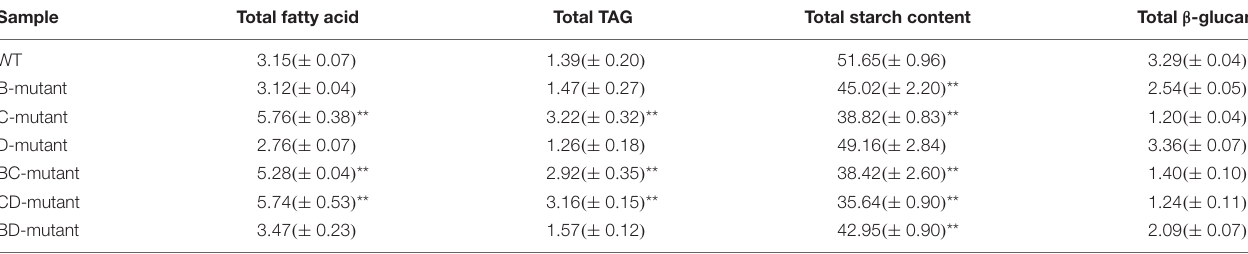
TABLE 1 | Total content of fatty acid, TAG, starch and β -glucan of WT- and double-mutant lines.